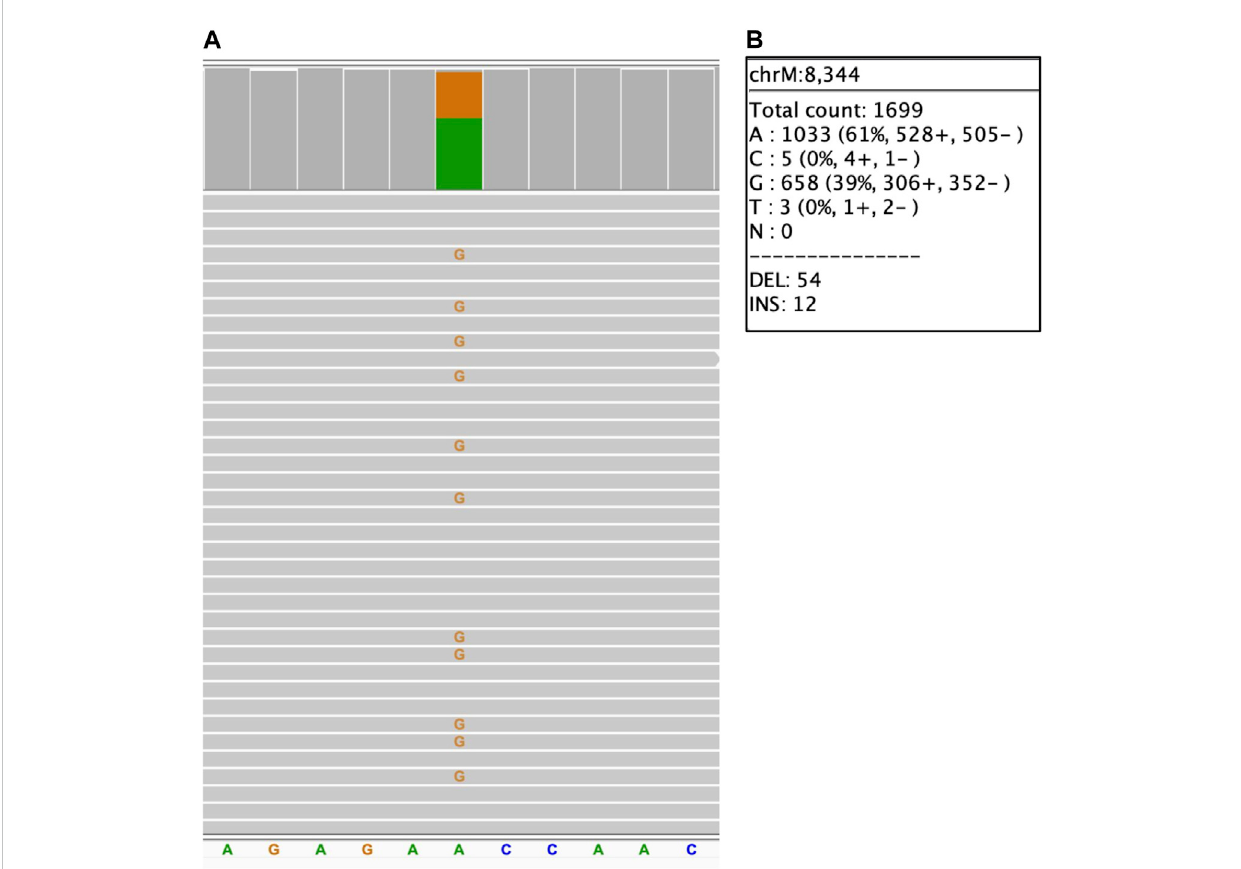
FIGURE 3 Mitochondrial small sequence change with heteroplasmy. NA11906 sample. (A) MTTK_chrM_m.8344A > G single nucleotide variant, alignment view of the long read WGS. Each thick gray horizontal line represents a separate read. Top of each panel represents a local coverage depth and color coded whenapplicabletoindicatenucleotidevariabilityatthecorrespondingposition.Stringoflettersbelowthepanelindicatereferencenucleotidesequence, and colored nucleotides over the read sequences stand for the alternative allelic variants. Due to the very high depth of coverage for the mitochondrial variants ( > 1,000x), the image shows only a small fraction of reads; (B) MTTK_chrM_m.8344A > G heteroplasmy level detected with long reads